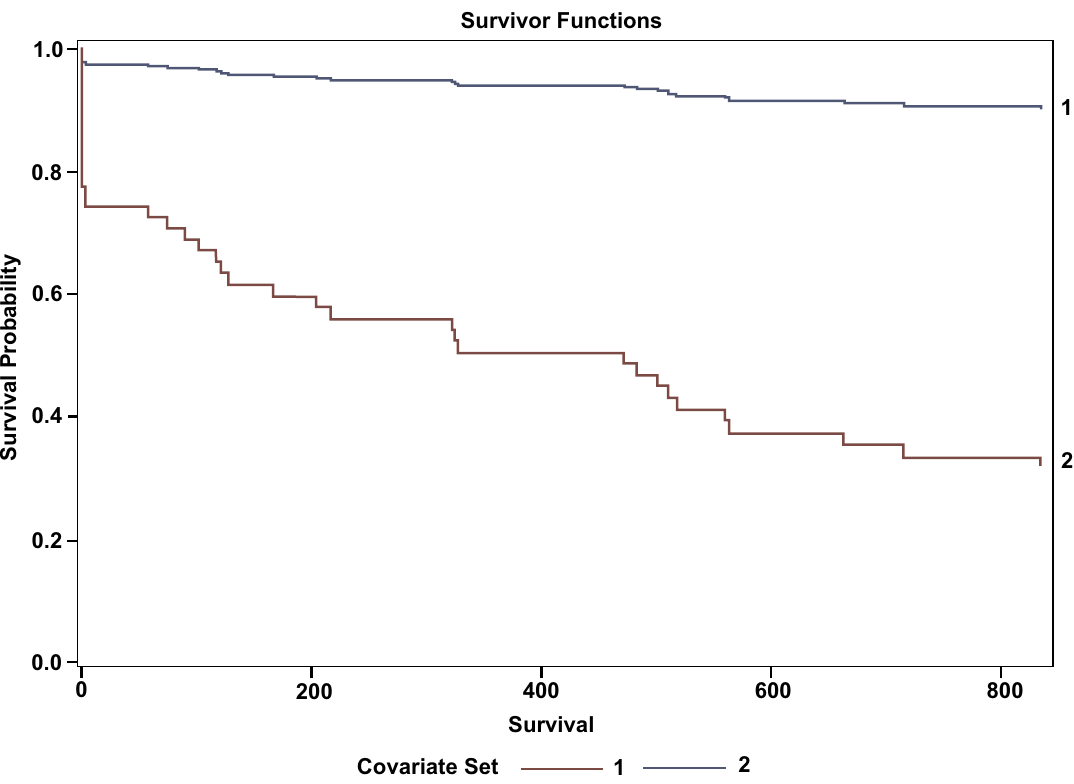
Figure 14. Estimated survival (days) curves for patients with PC from ovarian origin. 1: 37°C; 2: 42°C. All at 579 minutes operation time (mean).